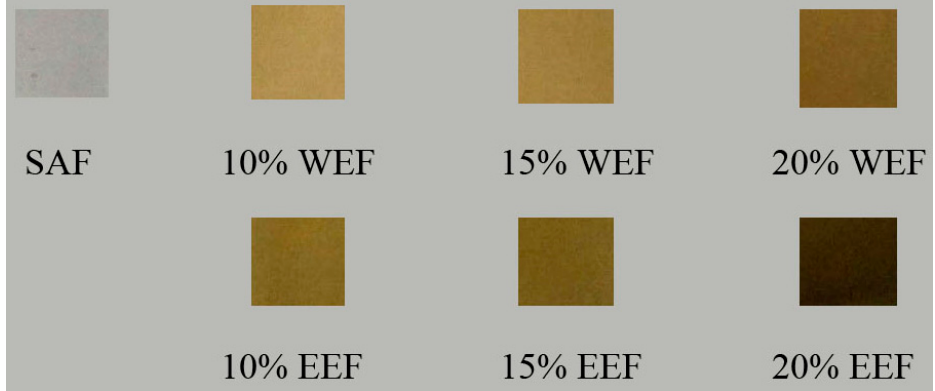
Table 2. Color parameters of the different films.